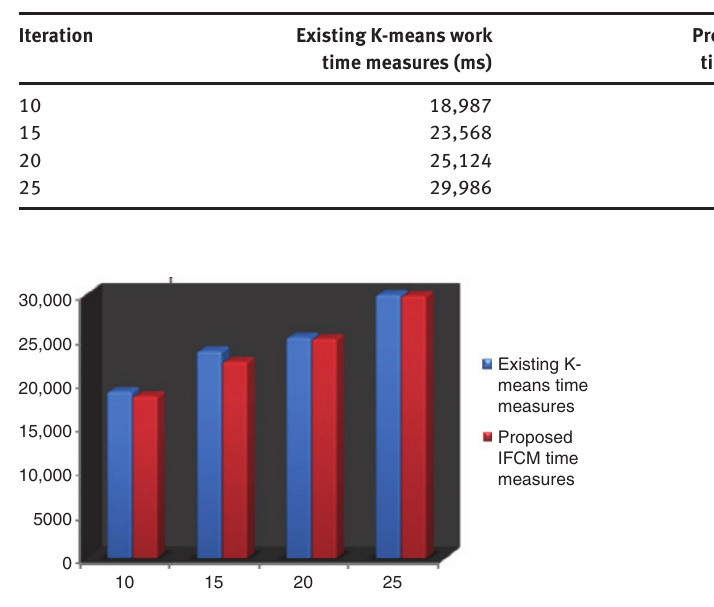
Figure 6: Graphical Representation for Proposed and Existing Time